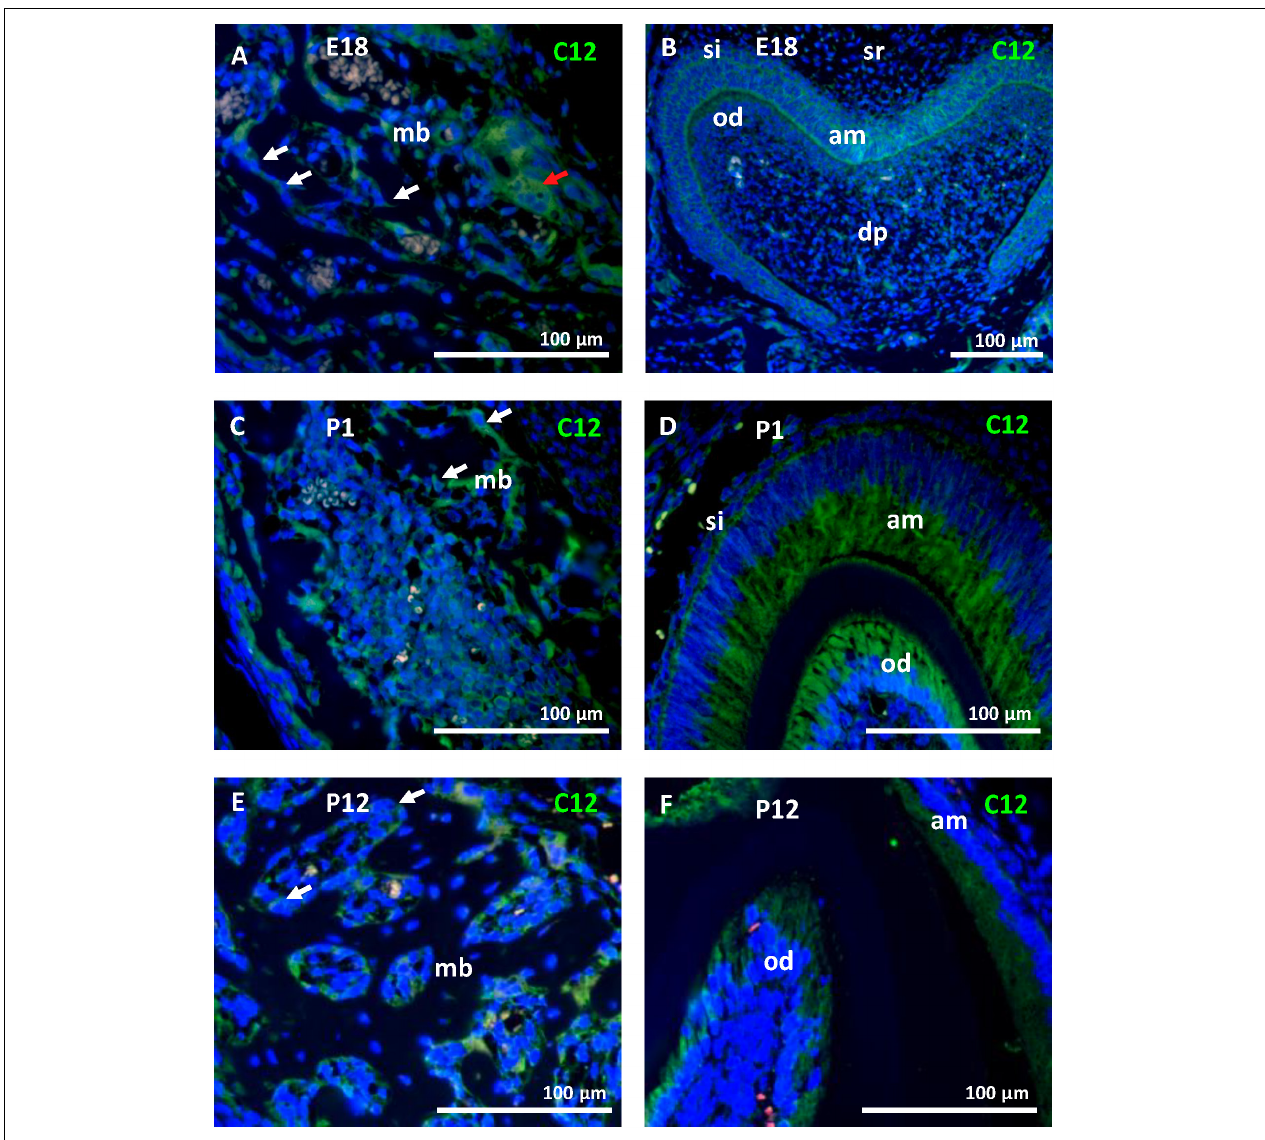
FIGURE 3 | Caspase-12 protein in perinatal and postnatal development. Immunofluorescence analysis of caspase-12 (green) in mandibular bone and the first lower molar at perinatal stages (E18 and P1) and postnatal stage P12. Caspase-12 was localized in the mandibular bone, predominantly in osteoblasts (A,C,E) at all of these stages. In the developing tooth, caspase-12 was positive mainly in ameloblasts and odontoblasts (B,D,F) . Scale bar: 100 µ m, counterstained by DAPI (blue). White arrows point to osteoblasts, a red arrow points to osteoclasts. mb, mandibular bone; si, stratum intermedium; sr, stellate reticulum; dp, dental pulp; am, ameloblasts; od,